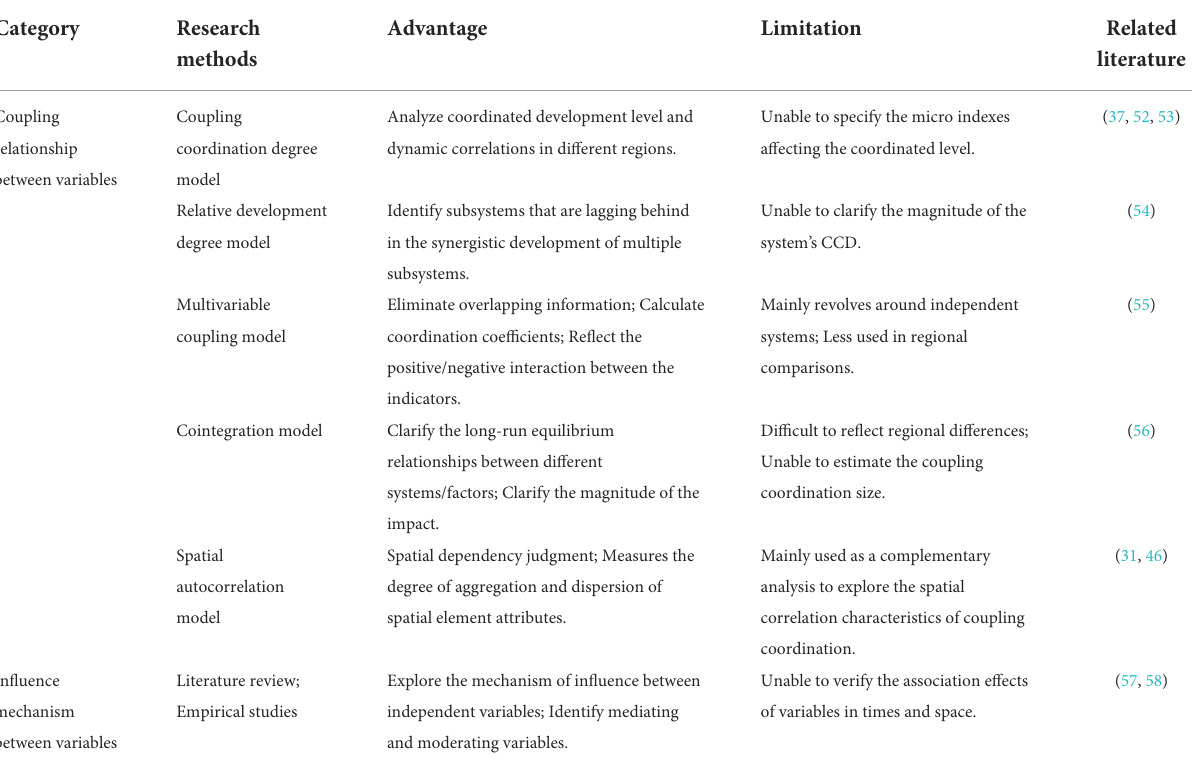
TABLE 1 Review of research